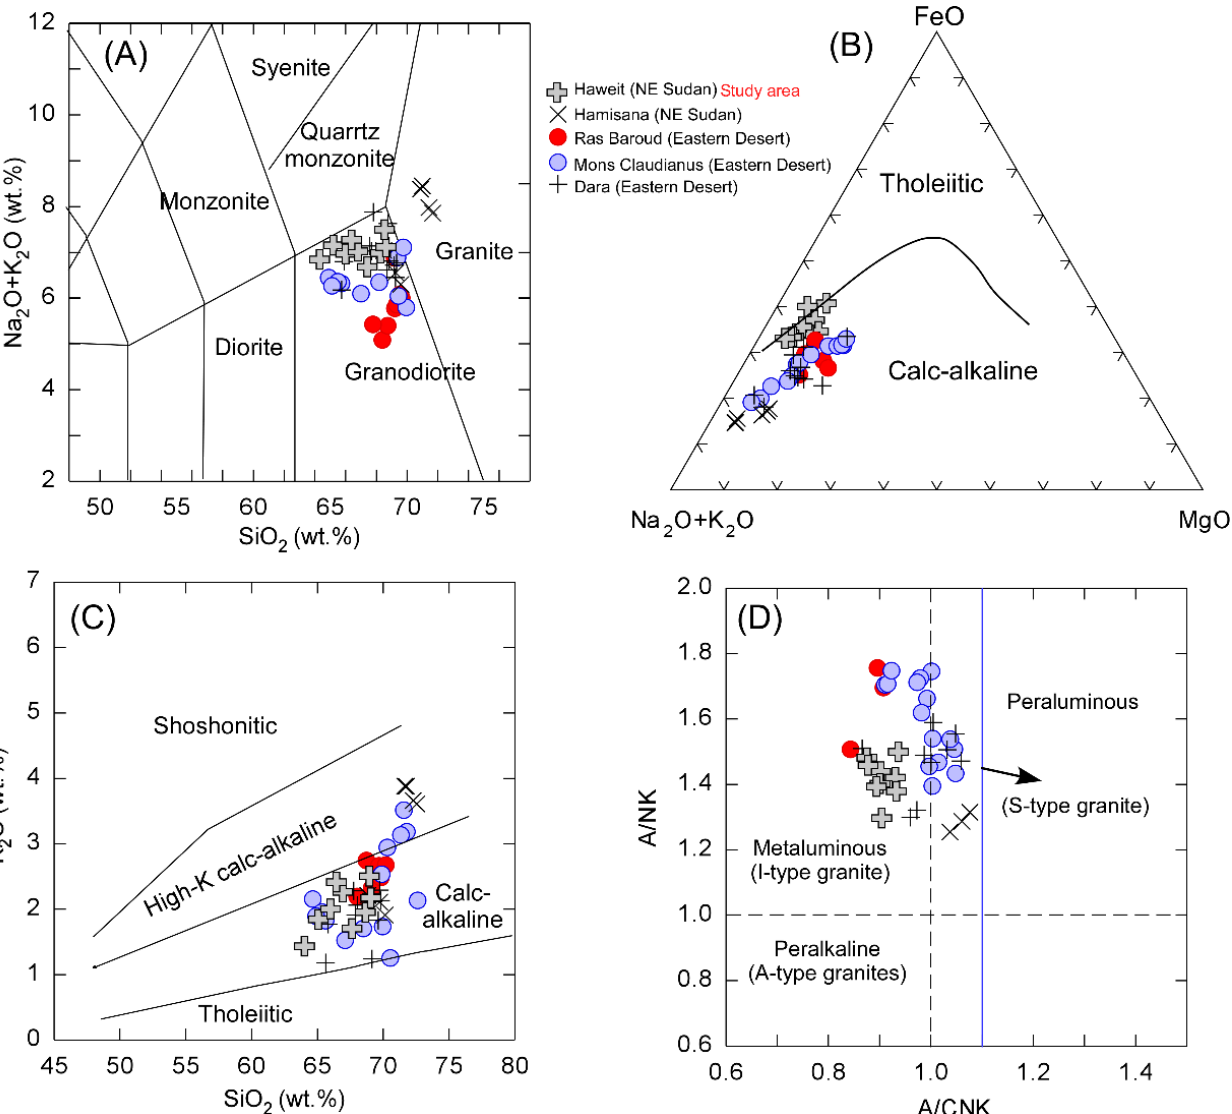
Figure 4. Whole ‐ rock composition of the Haweit granodiorite. ( A ) TAS diagram [37], showing the classification of the studied granodiorites; ( B ) discrimination diagrams Na 2 O + K 2 O ‐ FeO ‐ MgO ternary diagram for tholeiitic and calc ‐ alkaline magma series [38]; ( C ) K 2 O versus SiO 2 diagram [39]; and ( D ) A/NK (molar Al 2 O 3 /Na 2 O + K 2 O) vs. A/CNK (molar Al 2 O 3 /CaO + Na 2 O + K 2 O) [40], showing that almost all samples have a metaluminous signature. The data of other granodiorite samples from various localities in the Nubian Shield, including Hamisana [13], Ras Baroud [41], Mons Claudianus [42], and Dara [43], are used for comparison. Table 2. Analytical data of whole ‐ rock major and trace elements and related parameters of the Haweit granodiorites, NE Sudan.